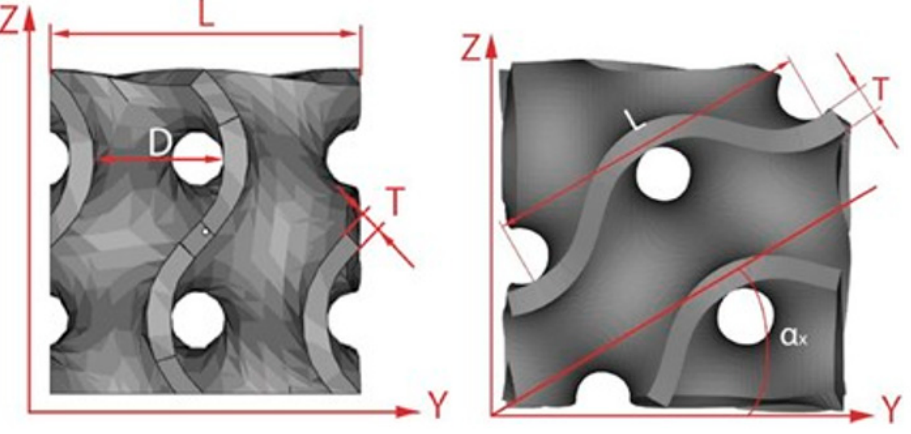
Figure 1. Geometrical factors of an elementary unit cell.